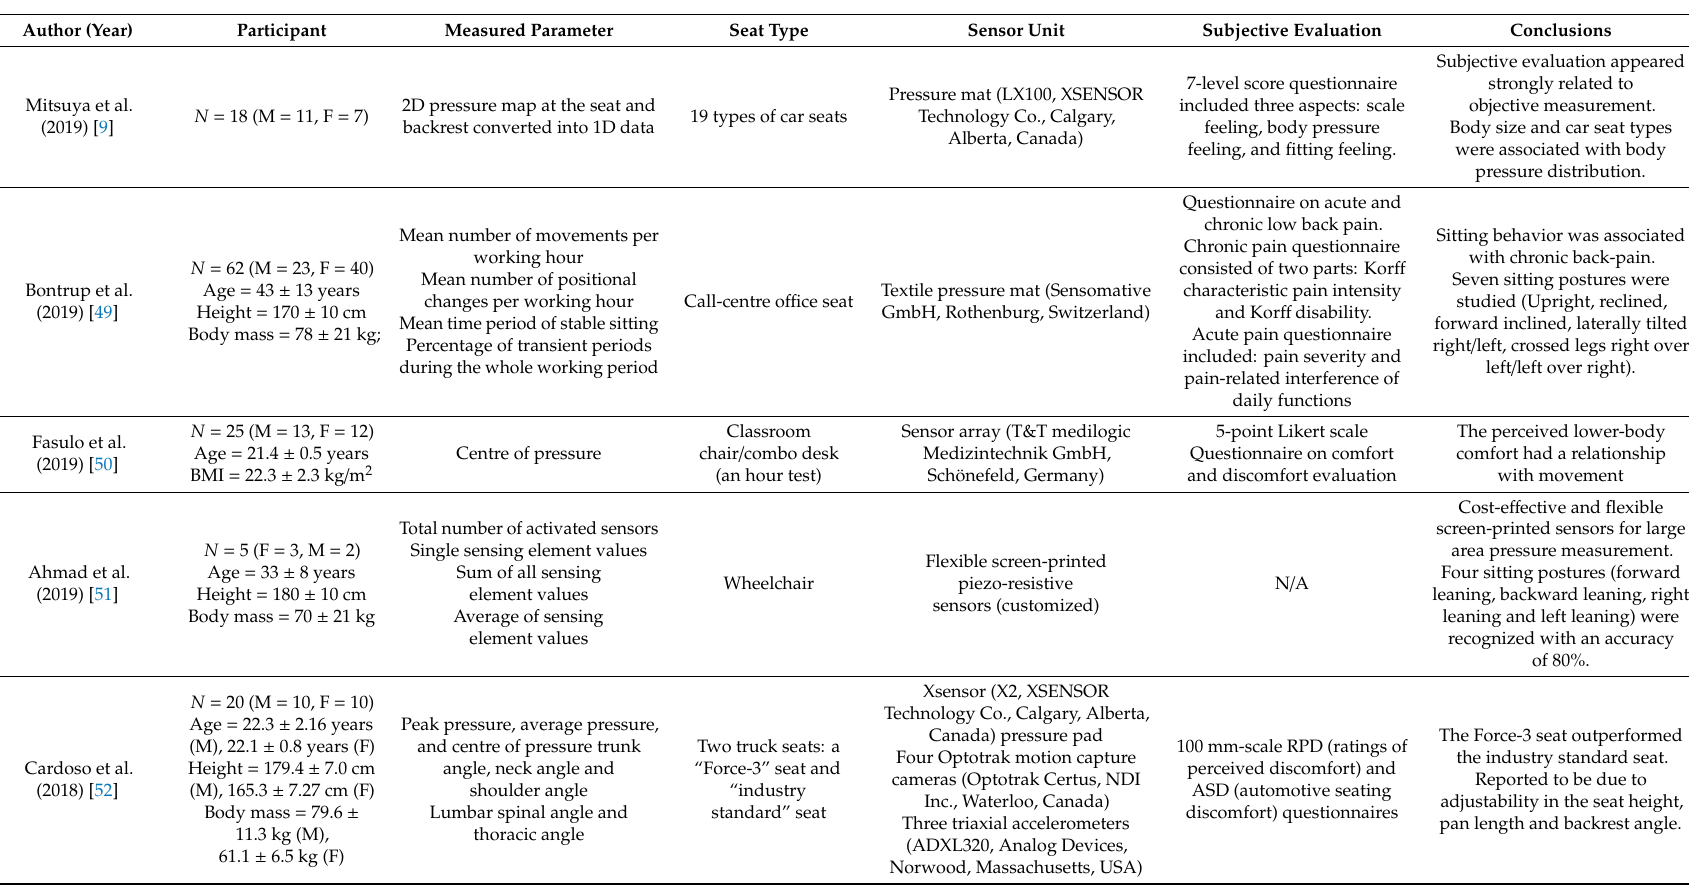
Table 2. Overview of literature (listed in reverse chronological order) on pressure measurement at the body–seat interface where some studies compared the pressure information with subjective